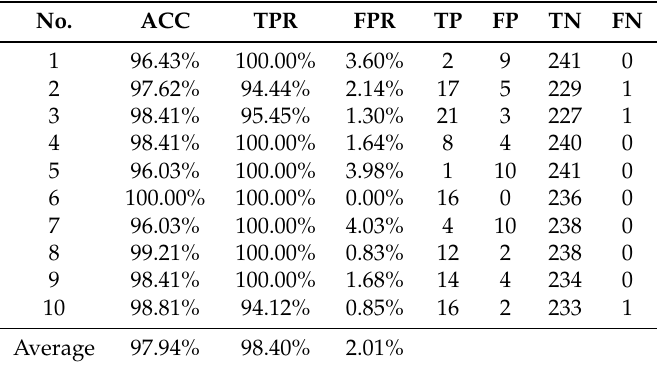
Table 5. The evaluation results of the event-class predictor.